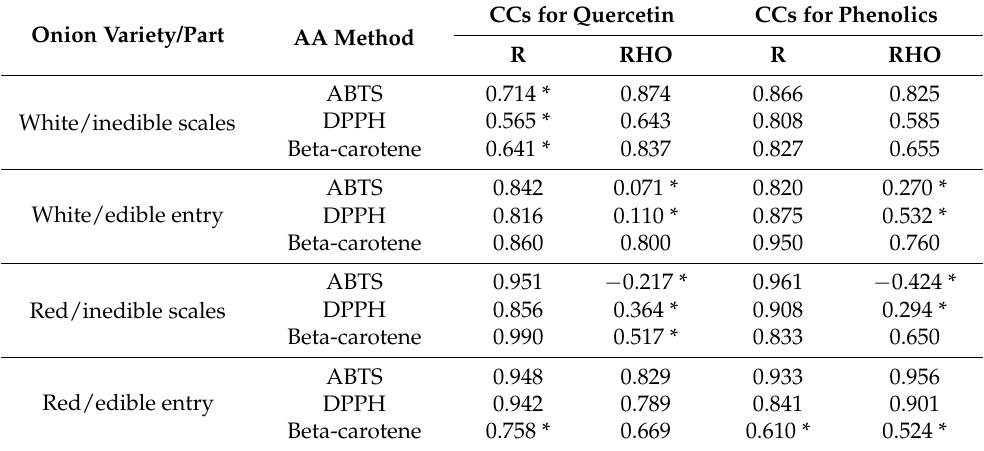
Table 3. The Pearson’s (R) and Spearman’s (RHO) correlation coefficients (CCs) between the content of quercetin/phenolics and antioxidant activity determined by ABTS, DPPH, and β -carotene bleaching assays for the PHWE extracts obtained in the range of 50–175 ◦ C from the edible and inedible parts of white and red onions ( p < 0.05). CCs for Quercetin Onion Variety/Part AA Method